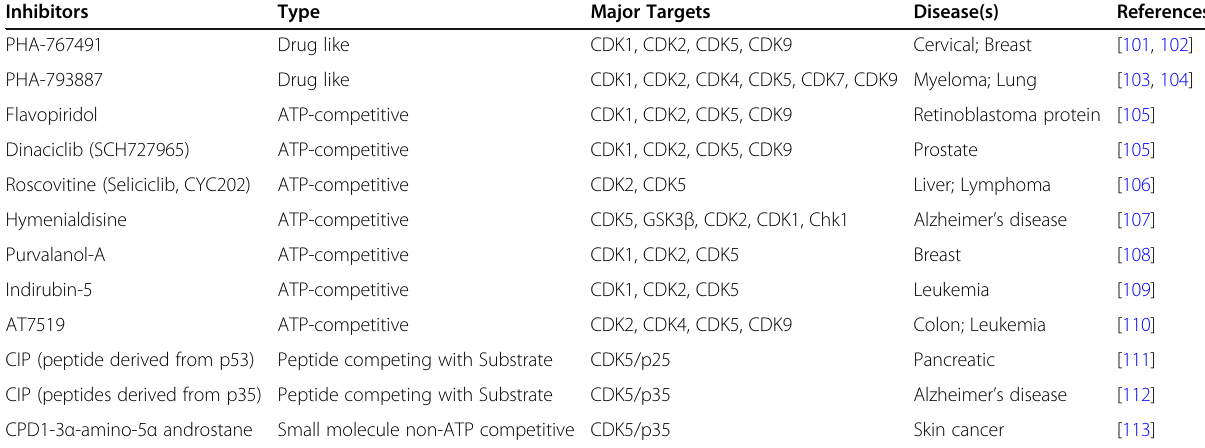
Table 4 Summary of CDK5 inhibitors